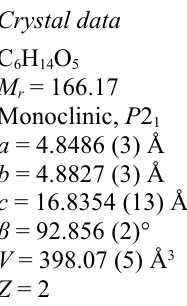
The packing diagram for the title compound projected along the b -axis. Hydrogen bonds are shown as dotted lines.